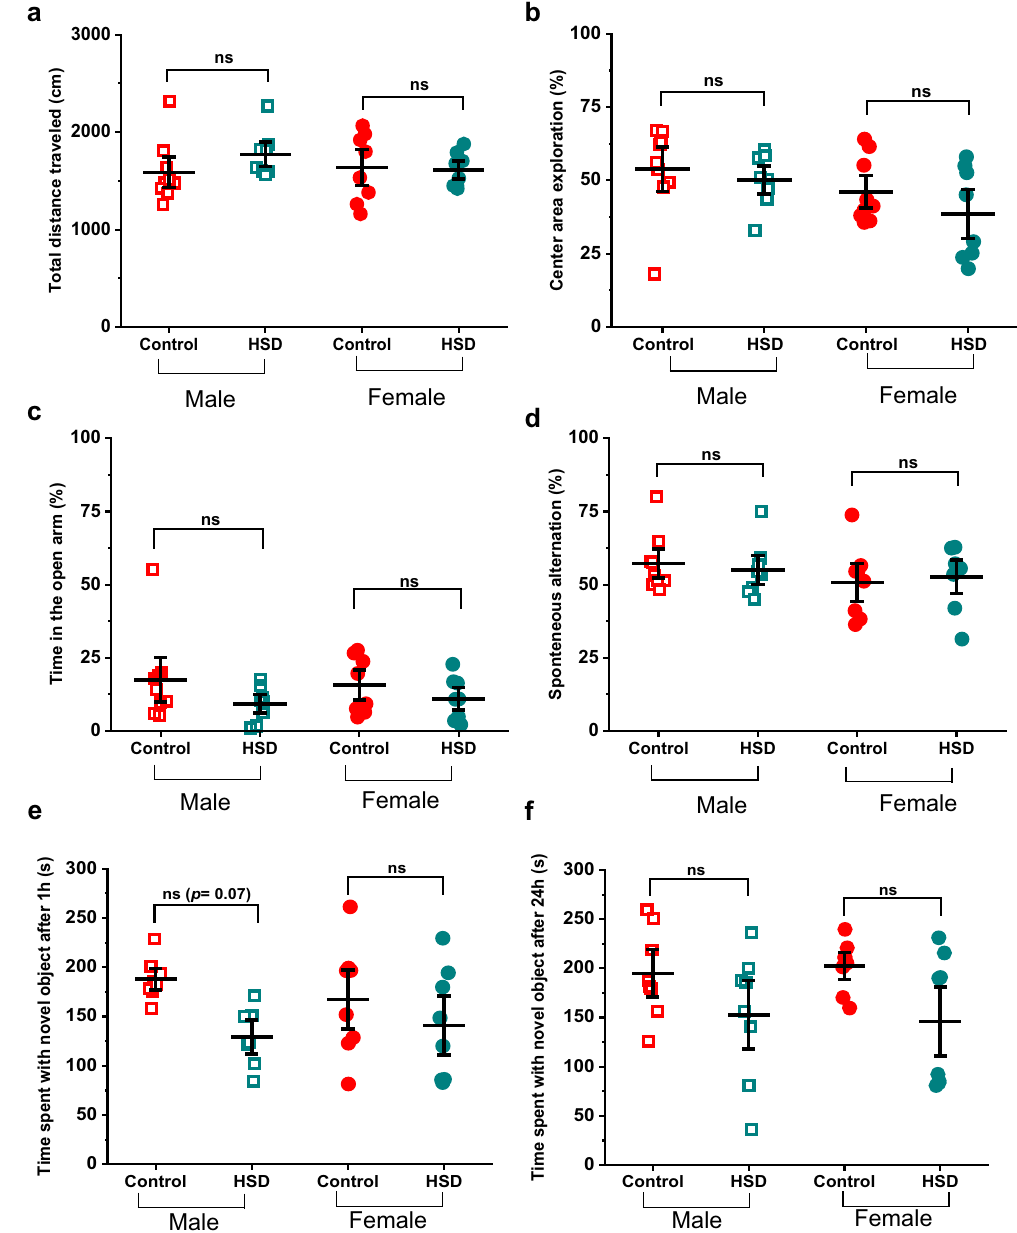
Figure 2. HSD does not alter exploratory behavior or memory tasks performance in the parental generation. The behavioral tests used were open field test (OFT), elevated plus maze (EPM), T-maze spontaneous alternation test and novel object recognition (NOR) test (n = 9 control males, 8 HSD males, 8 control females, 8 HSD females). Overall, no difference was observed in exploratory behavior in HSD-fed groups: ( a ) total distance traveled in the OFT, ( b ) time spent in the center area of the OFT, or open arm exploration in EPM ( c ). In addition, HSD-fed mice do not show memory impairment in the T-maze spontaneous alternation test ( d ), or in the NOR test after 1 h ( e , although there is a clear trend toward reduced memory in HSD-fed male mice but it did not reach statistical significance). NOR test after 24 h shows similar results, no difference in memory performance ( f ). Data are described as mean ± SEM. * p < 0.05, ** p < 0.01, *** p < 0.001, one-way ANOVA and Tukey’s